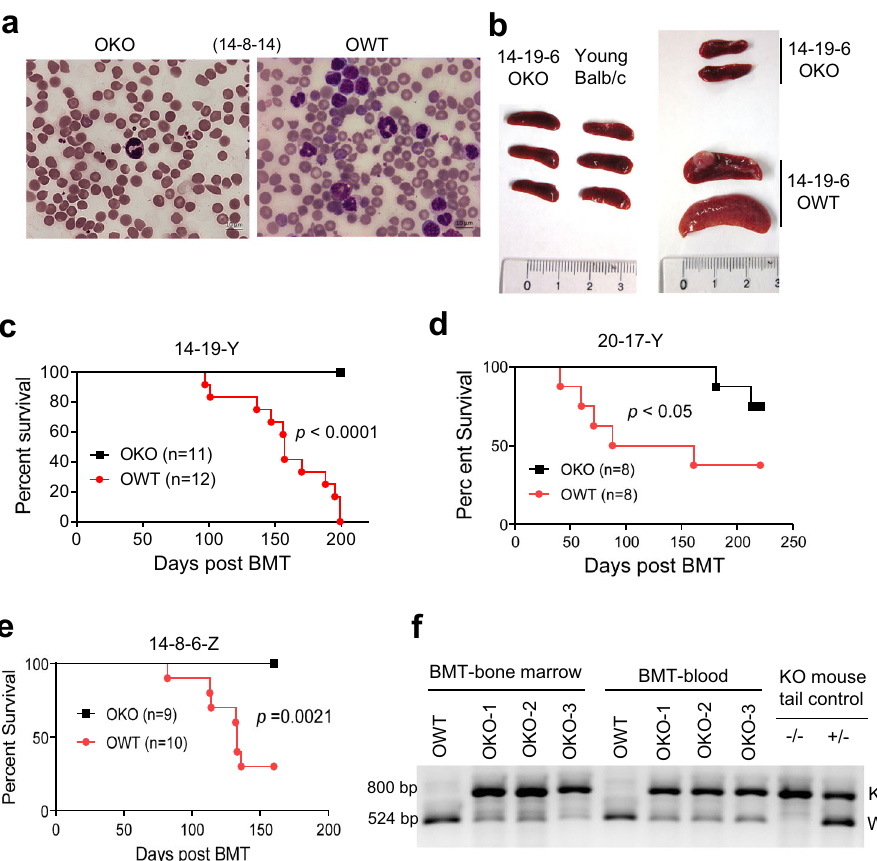
Fig. 3 SIRT1 knockout inhibited spontaneous acute leukemia in 2nd and 3rd BMT recipients. a Representative blood smear of 2nd BMT mice (14-8- 14 series). b Splenomegaly in 14-19-6 BMT recipients with WT, but not SIRT1 knockout, donor cells. Noted a lymphoma nodule on one WT spleen. c – e Survival curves of 2nd BMT recipients (14-19-Y series in c and 20-17-Y series in d ) and 3rd BMT recipients (14-8-6-Z in e ). f PCR con fi rmation of donor cell identity in bone marrow and blood of 2nd BMT recipients. Residual WT DNA seen in OKO recipients was due to minor contamination of recipient